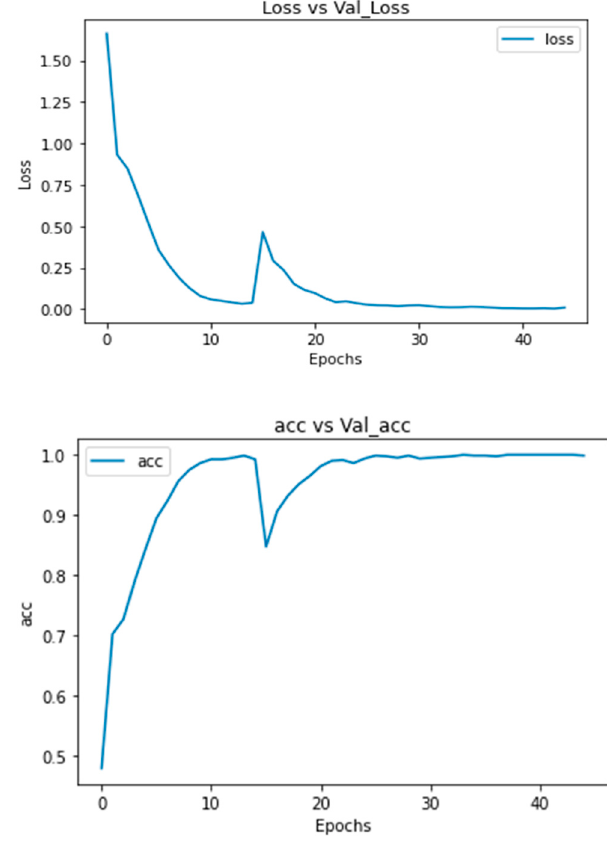
Figure 11. Comparison of classifiers.